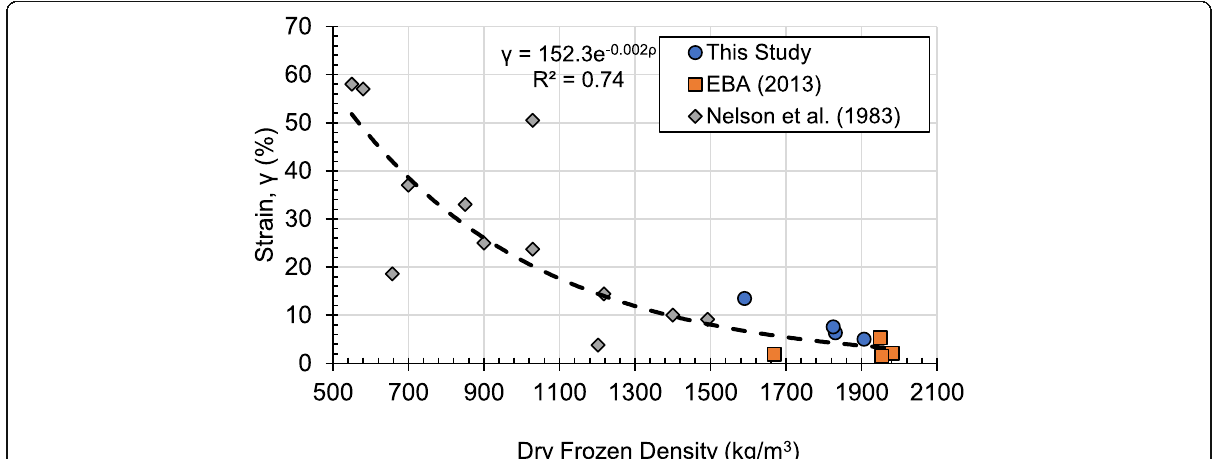
Fig. 7 Percent strain as related to dry frozen density for silt and clay